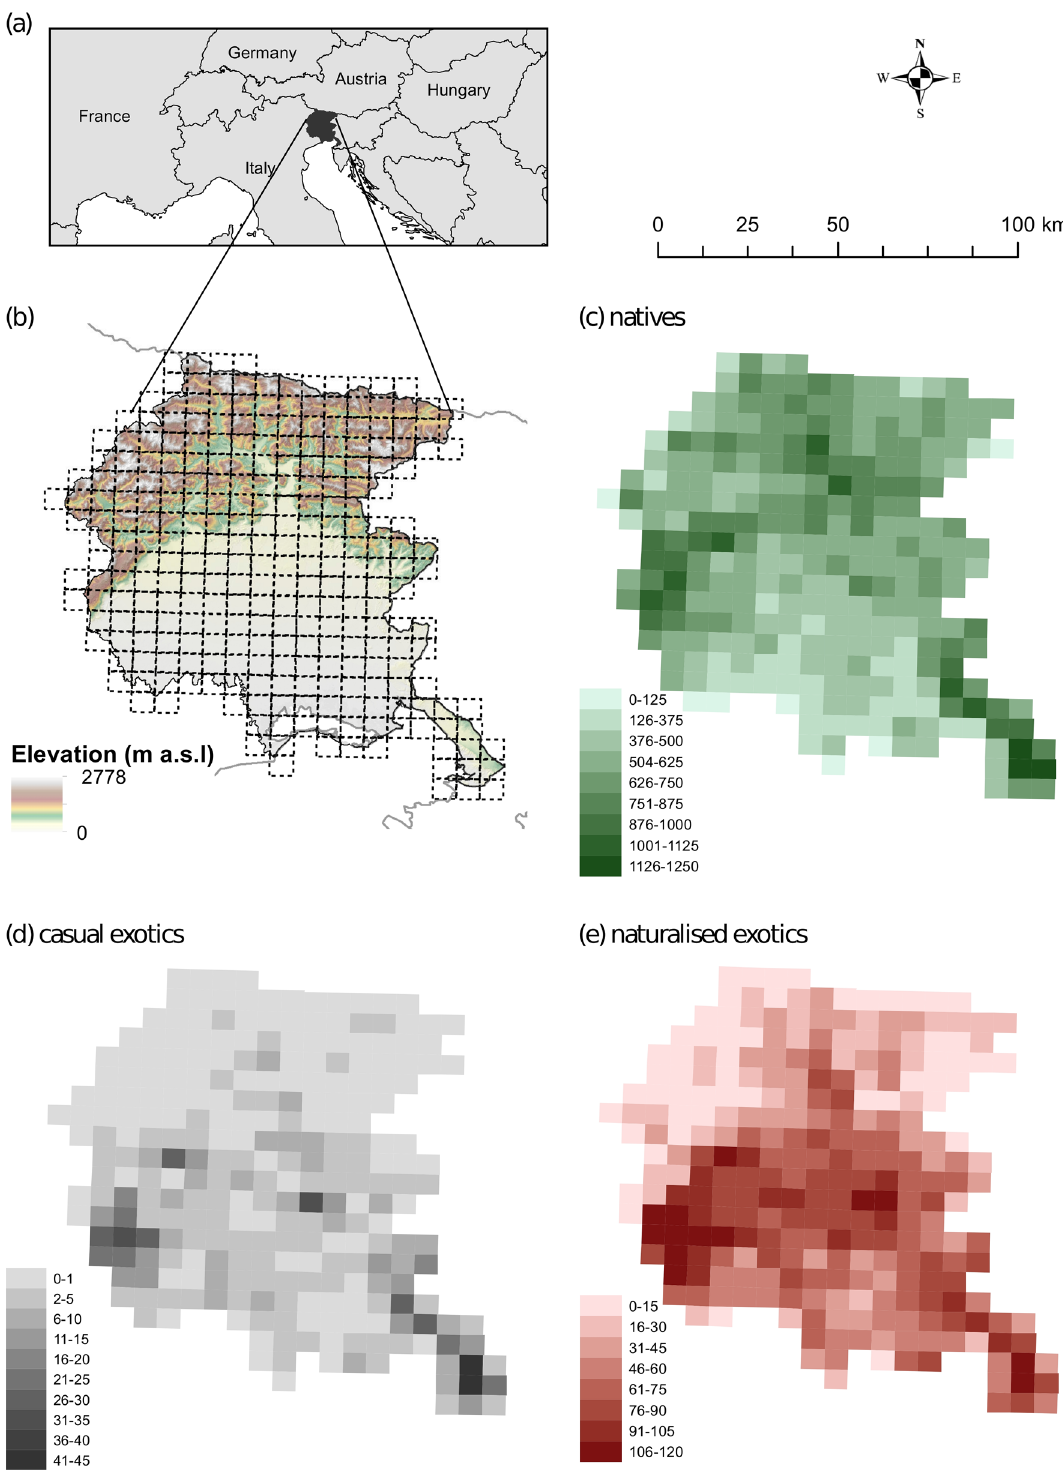
Figure 1. Location of the study area ( a ) and species richness in each grid cell of the three categories of native ( c ), casual exotic ( d ) and naturalised exotic species ( e ). Changes in elevation in the study area and position of grid cells based on the Central European grid for floristic surveys are also reported ( b ). Figure was realised using ArcGIS 10.0